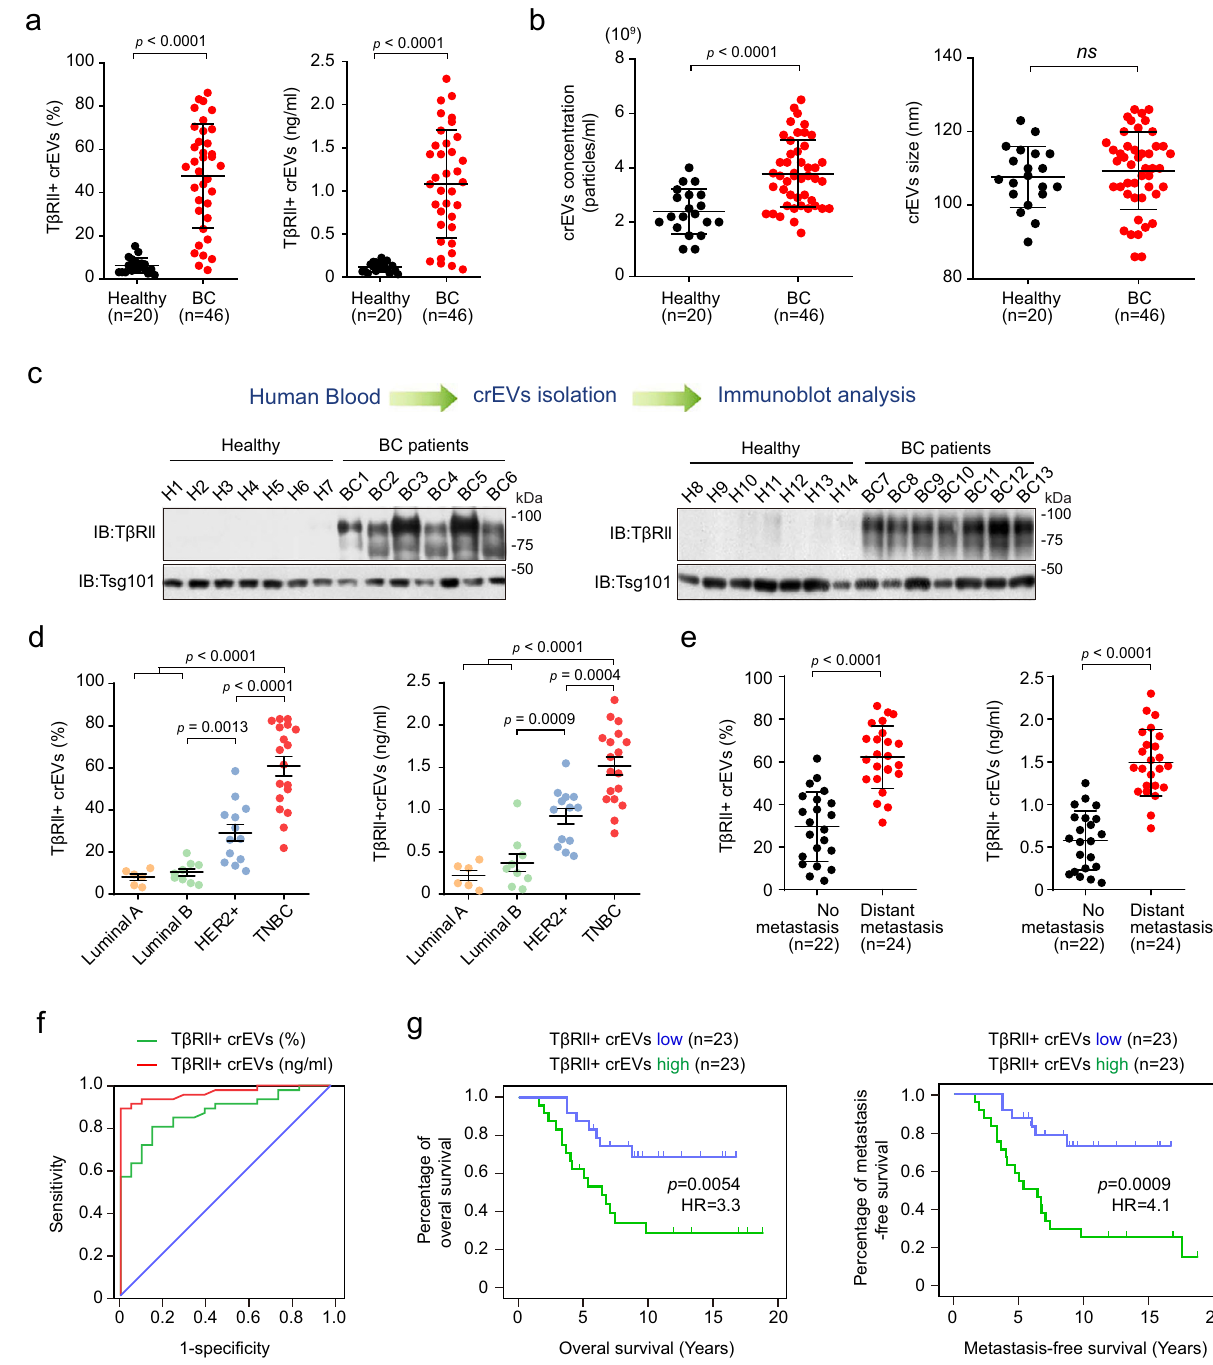
Fig. 3 The amount of T β RII on circulating EVs distinguishes patients with breast cancer from healthy donors. a FACS analysis (left panel) of the percentage of T β RII + crEVs and ELISA (right panel) of T β RII on crEVs in plasma samples from healthy donors ( n = 20 samples) and patients with breast cancer ( n = 46 samples). The number of particles used in each FACS-based assessment is the same (10,000 events per sample). b Nanosight analysis of the concentration (left) and size (right) of the T β RII + crEVs in plasma from healthy donors ( n = 20 samples) and patients with breast cancer ( n = 46 samples). c Immunoblot analysis of crEVs in plasma from healthy donors ( n = 14 samples, H1-H14) and patients with breast cancer ( n = 13 samples, BC1-BC13). The protein loading of EVs of healthy and BC samples was equal. d FACS (left panel) and ELISA (right panel) of T β RII + crEVs in breast cancer patients of different subtypes (Luminal A, n = 6 samples; Luminal B, n = 9 samples; HER2 + , n = 13 samples; TNBC, triple-negative breast cancer, n = 18 samples). e FACS (left) and ELISA (right) of T β RII + crEVs in patients with no metastasis ( n = 22 samples) and patients with distant metastasis ( n = 24 samples). f ROC curve analysis for the indicated parameters in patients with breast cancer ( n = 46 samples) compared to healthy donors ( n = 20 samples). g Kaplan-Meier curves (log-rank test) displaying overall (left panel) and metastasis free (right panel) survival of patients with a high (>46%, FACS-detected level) T β RII + crEVs (green), and with a low (<46%, FACS-detected level) T β RII + crEVs (blue). * p < 0.05 (two-tailed Student ’ s t test a , b , d , e or two-way ANOVA f , g ). Data are analyzed of three independent experiments and shown as mean ± SD a , b , d , e . Source data are provided as a Source Data fi